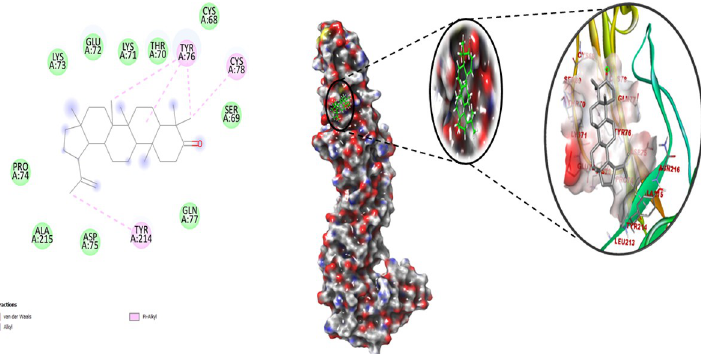
Fig 3. Best docked pose of Lupenone with 2ALA displaying 2D interaction plot on the left panel. Pink dashed lines indicate the Pi-Alkyl bond and residues embedded in the light green sphere, indicating involvement in Van der Waals interactions. On the center panel, surface view of 2ALA displaying binding cavity of Lupenone and right panel displays the zoomed out binding pocket having amino acid residues at 3 Å surrounding the Lupenone molecule.